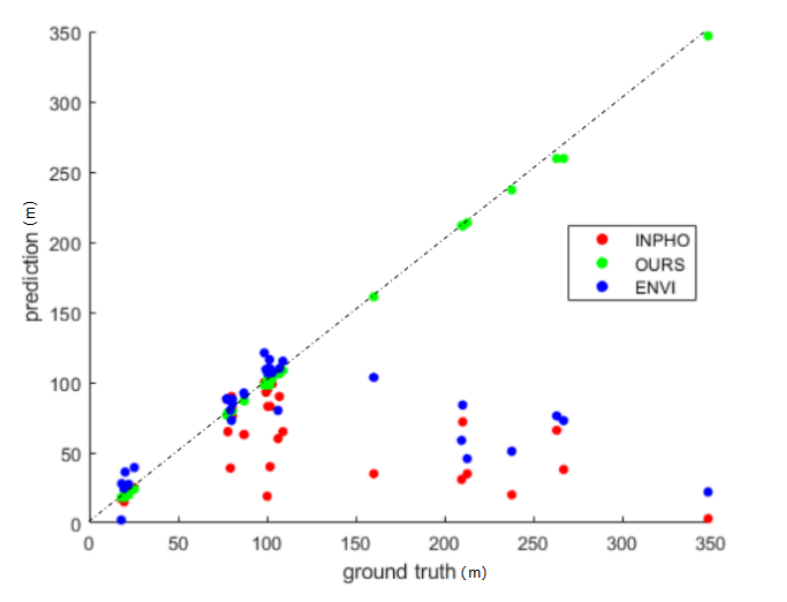
Figure 20. The distribution of estimated and ground truth building elevation. Table 7. Accuracy statistics of experimental results in the